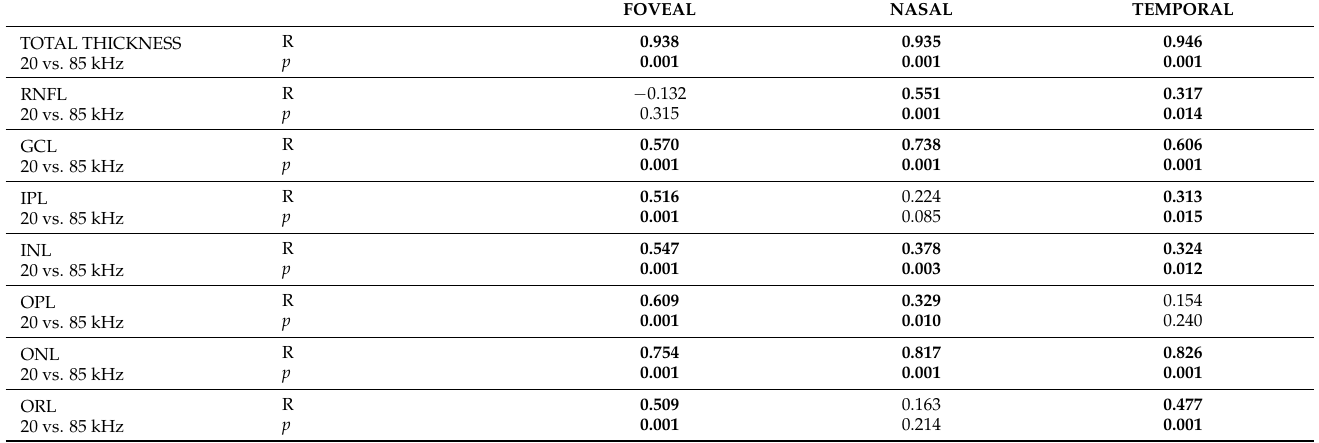
Table 5. Spearman’s correlation index (R) between the two matching retinal layers’ thickness mea- sured with a 20 kHz and an 85 kHz A-scan rate in the foveal, nasal, and temporal areas. The bold values are statistically siginificative ( p < 0.05) (RNFL: retinal nerve fiber layer; GCL: ganglion cell layer; IPL: inner plexiform layer; INL: inner nuclear layer; OPL: outer plexiform layer; ONL: outer nuclear layer; ORL: outer retinal layer).